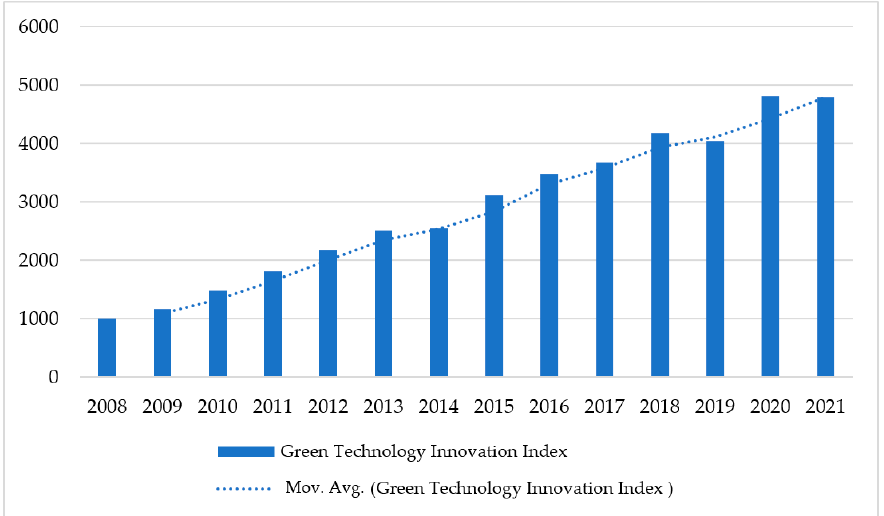
Figure 1. Green technology innovation index of Chinese enterprises. Note: Mov. Avg. represents the moving average of the green technology innovation index. Data source: Zero One Think Tank, https://www.01caijing.com (accessed on 5 July 2022).